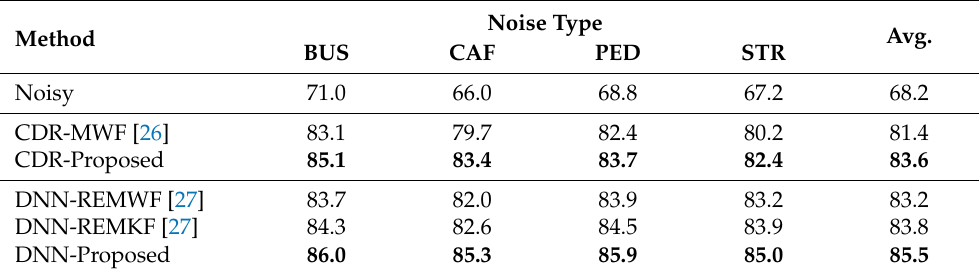
Table 2. The average eSTOIs (x100) for the different algorithms depending on the noise type.